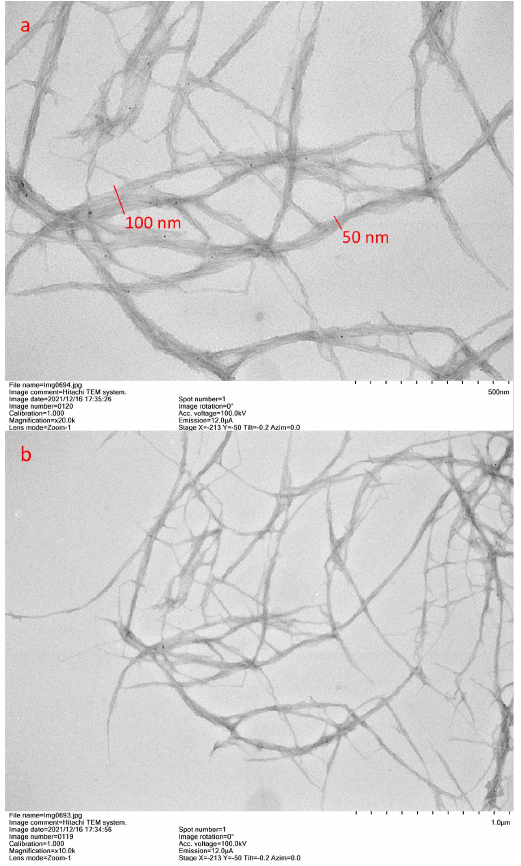
Figure 2. TEM images of prepared cellulose nanofibers: ( a ) 500 nm scale and ( b ) 1000 nm scale.